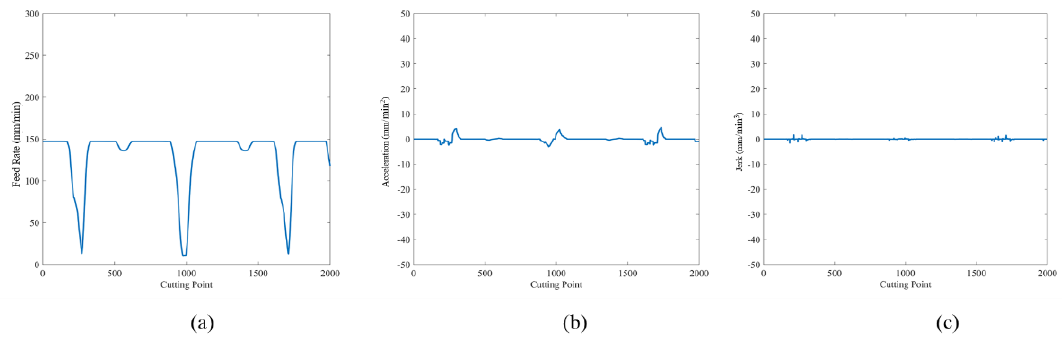
Figure 21. Cutting trident shape using our method with maximum feed rate of 150 mm/min: ( a ) feed rate, ( b ) acceleration, and ( c ) jerk.